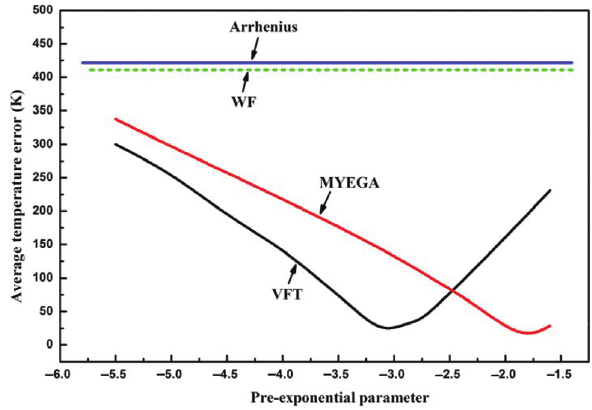
Figure 6: Prediction error in 10 10 Pa s isokom temperature for ten calcium aluminosilicate melts with different pre-exponential